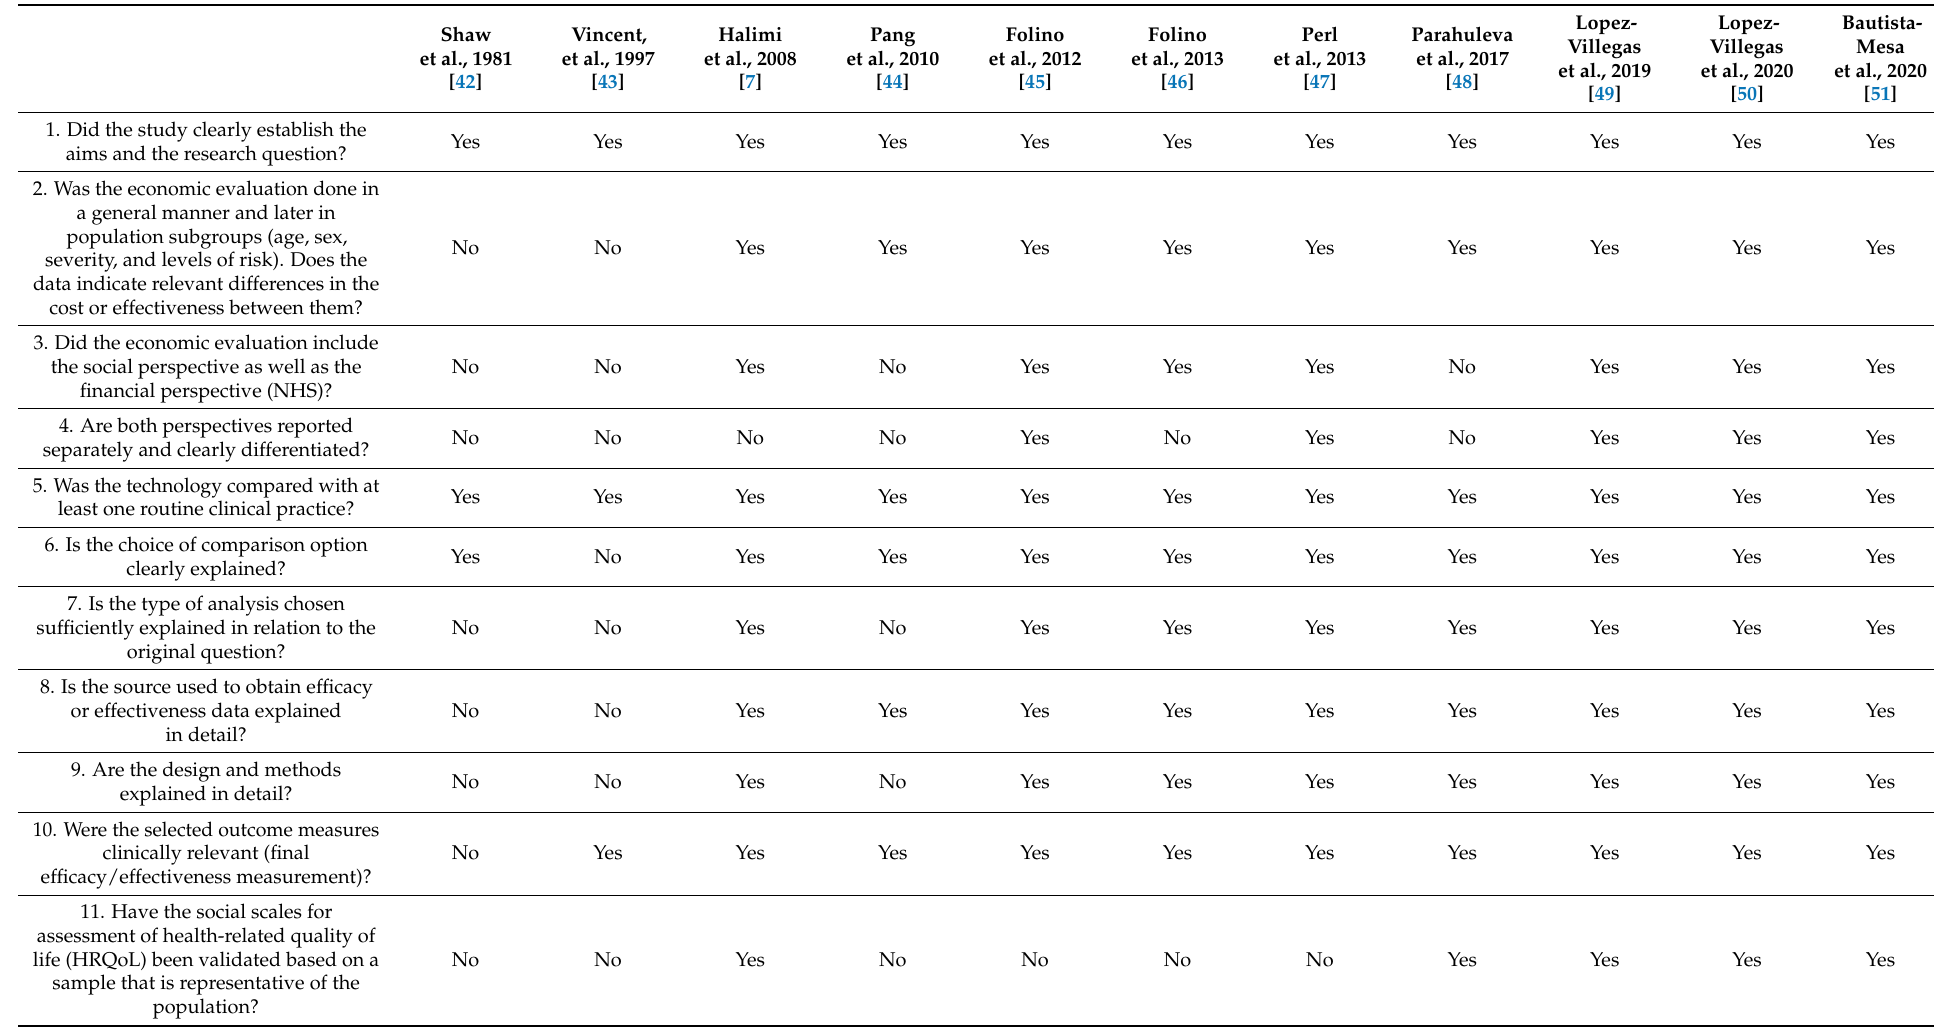
Table 4. Checklist for analyzing methodological quality of the